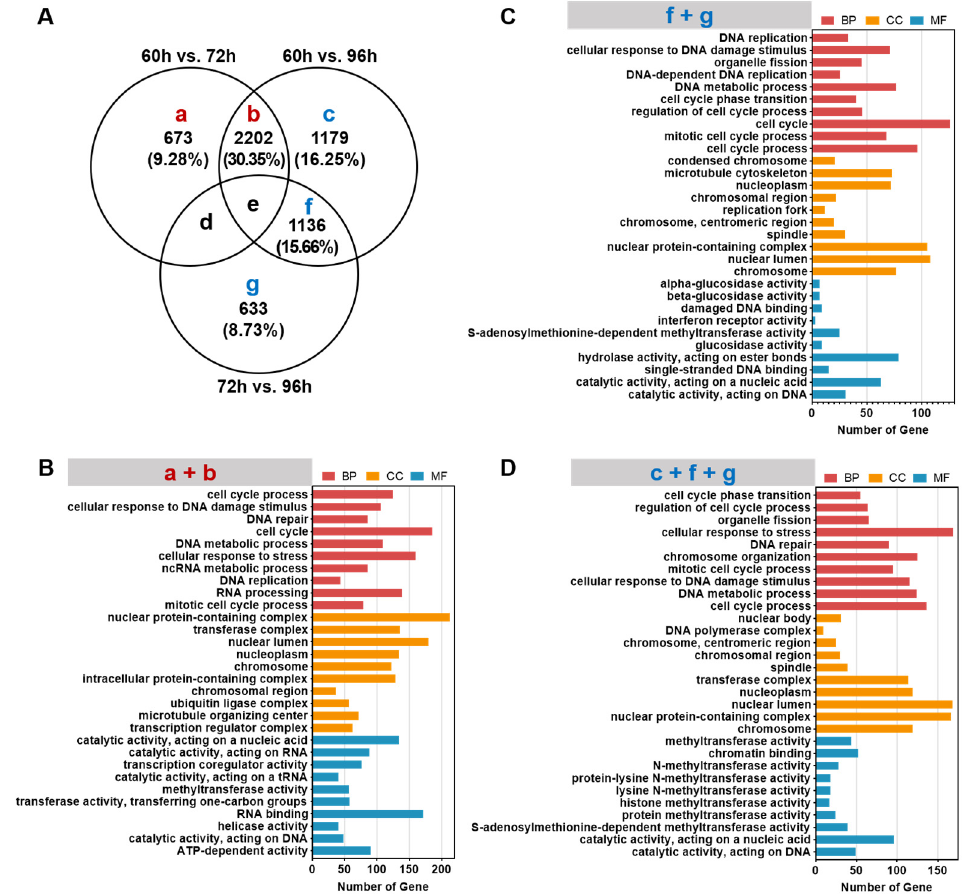
Figure 4. GO enrichment analysis of genes specifically expressed during different time periods of liver development. ( A ) The Venn diagram analysis of differentially expressed genes. a-g: different letters represent genes specifically expressed in different Venn groups. ( B ) GO enrichment analysis of genes specifically expressed in groups a and b that represent a class of genes specifically expressed in hepatocytes from 60 to 72 hpf. ( C ) GO enrichment analysis of genes specifically expressed in groups f and g that represent a class of genes specifically expressed in hepatocytes from 72 to 96 hpf. ( D ) GO enrichment analysis of genes specifically expressed in groups c, f, and g that represent all differentially expressed genes in hepatocytes between 60–72 hpf and 72–96